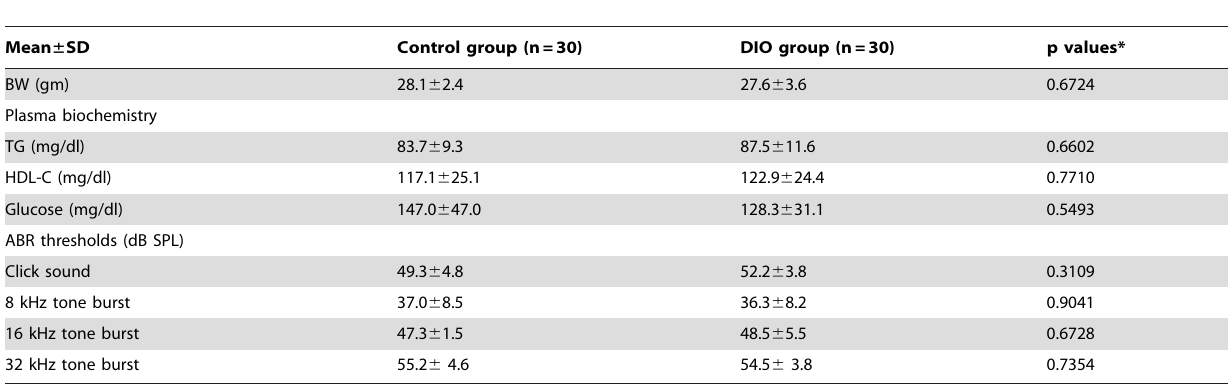
Table 1. Baseline characteristics of the both groups at the beginning of this study.